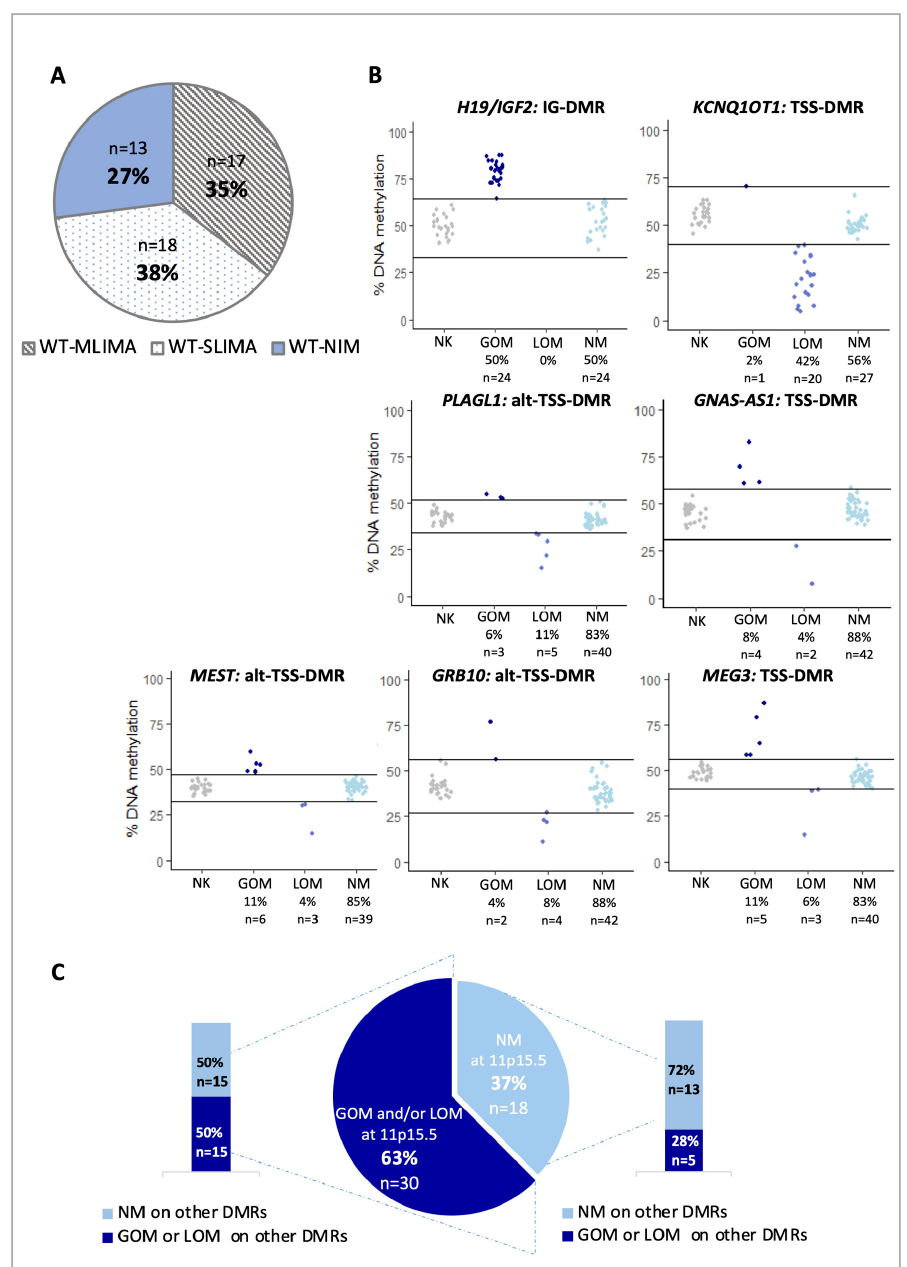
Figure 1. DNA methylation aberrations at imprinted loci in WTs. ( A ) Pie graph showing the number and percentage of the tumors with multi-locus imprinted methylation aberration (WT-MLIMA), the cases with single-locus imprinted methylation aberration (WT-SLIMA) and the cases with normal imprinted methylation (WT-NIM). ( B ) DNA methylation quantification at the indicated imprinted DMRs. The average methylation of the CpGs of each DMR in normal kidney (NK) and WTs was used to generate the dots graphs. Based on the DNA methylation profiles, WTs were stratified in three groups: patients with gain of methylation (GOM), loss of methylation (LOM), or normal methylation